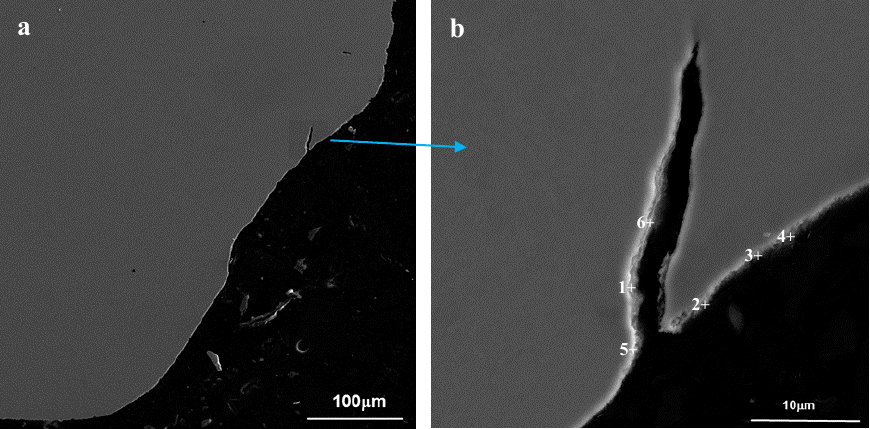
Figure 10. Cross sections specimen tested in Pb at 350 °C at R2 (2 × 10 − 8 m/s) showing the interface between the steel and the environment at the ( a ) notch originally covered by flux and Pb layer. In ( b ) detail of a crack with the point analyses reported in Table 6.